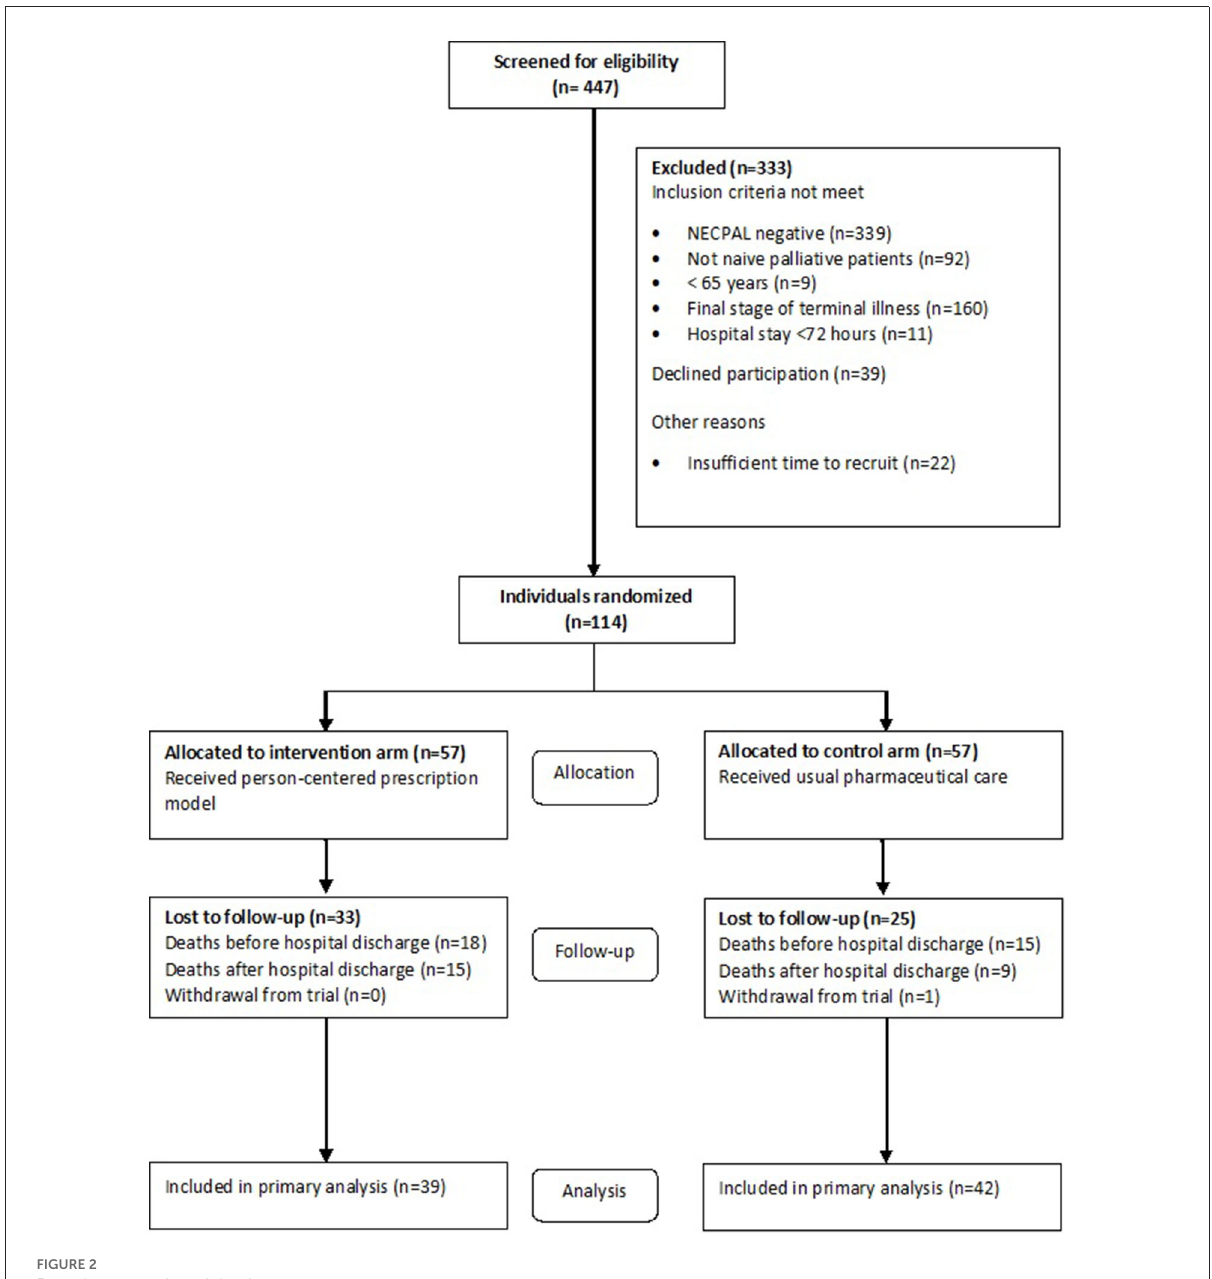
FIGURE2 Recruitment and